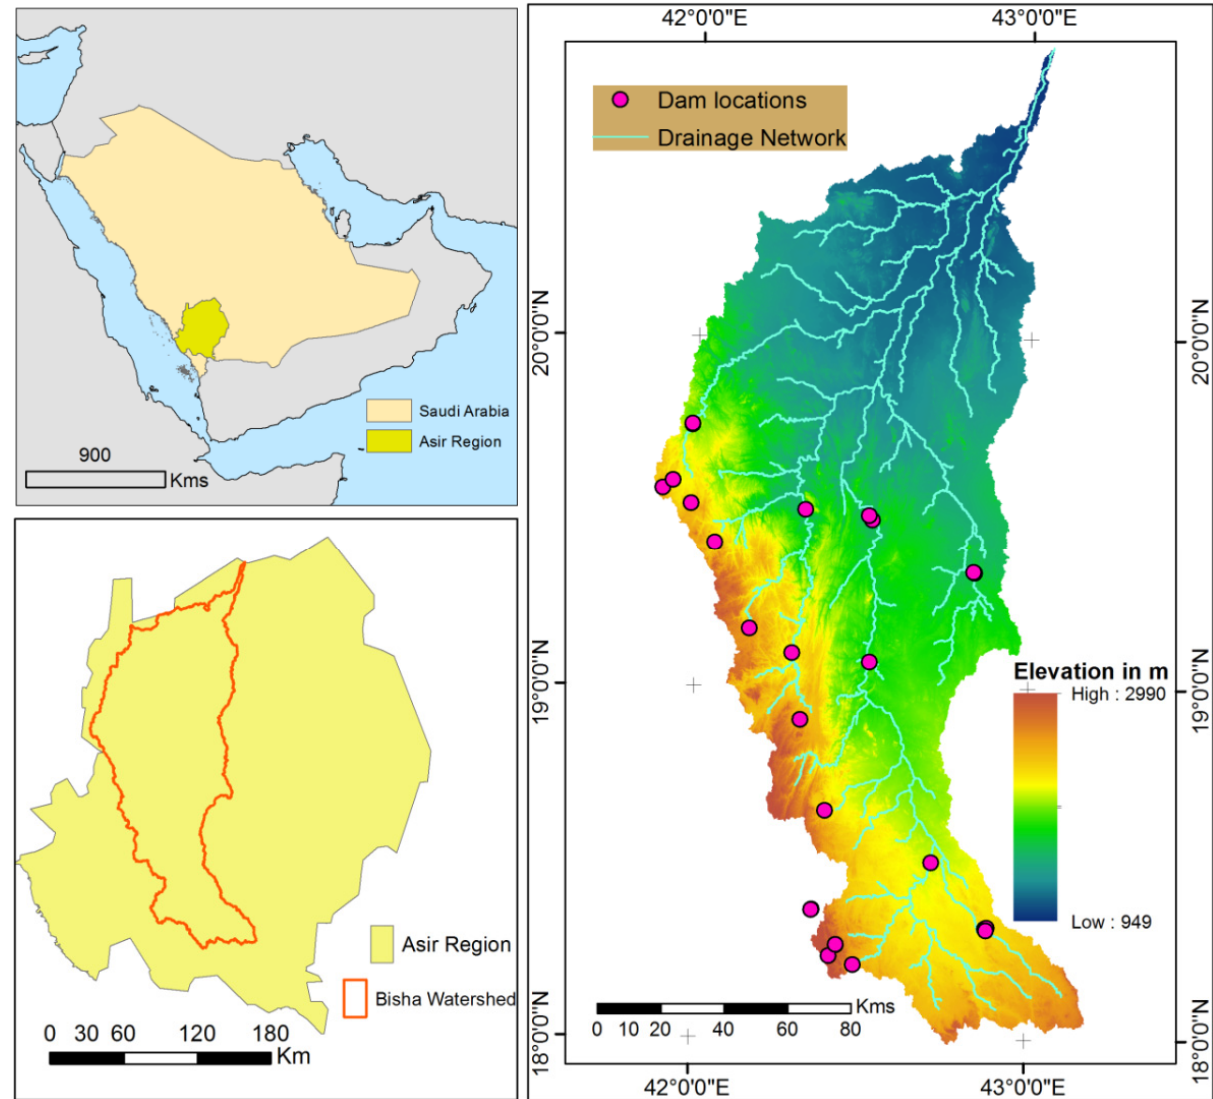
Figure 1. Study Area.